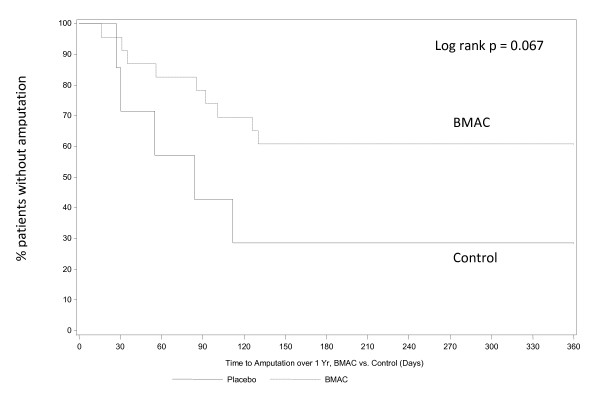
Time to Amputation over 1 year BMAC vs. Control (Rutherford 5 patients only). There were no amputations in the Rutherford 4 group, removing these patients results in separation of the BMAC and control curves and demonstrates a trend towards a positive treatment effect on amputation. (p = 0.067)